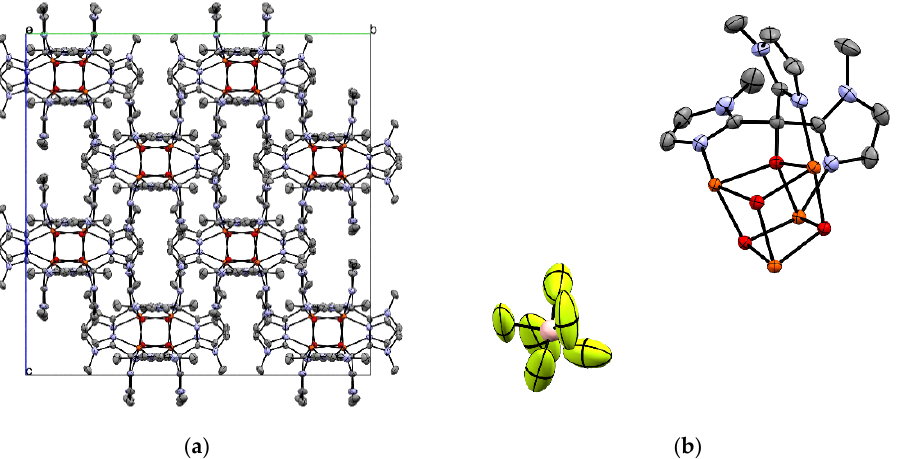
Figure 4. ( a ) Packing of [Fe 4 ((mim) 3 CO) 4 ](BF 4 ) 4 ( 3 ), BF 4 - anions and hydrogen omitted for clarity. ( b ) Distorted [Fe 4 -(µ 3 -O) 4 ]-cubane core in 3 decorated with imidazole ligands (3 ligands and hydrogen omitted for clarity). Color code: Fe orange, O red.